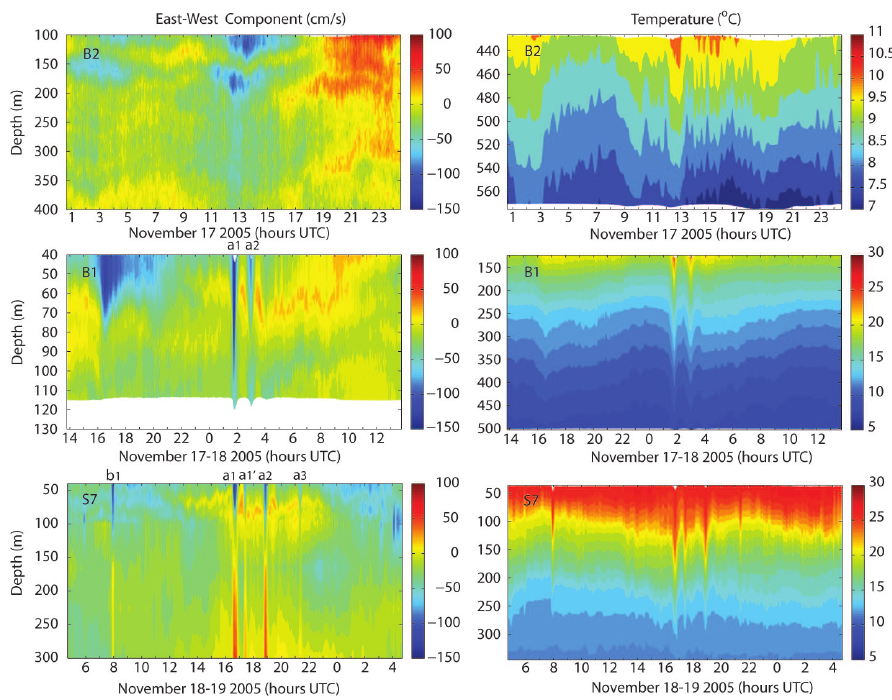
Fig. 2. Stack plots of (left) east-west velocity component and (right) temperature at moorings B2 (top), B1 (middle), and S7 (bottom) during 17–19 November 2005. The x-axes have been chosen to show the same soliton passing by, approximately aligned vertically. Speed and temperature scales are shown by the color bars.